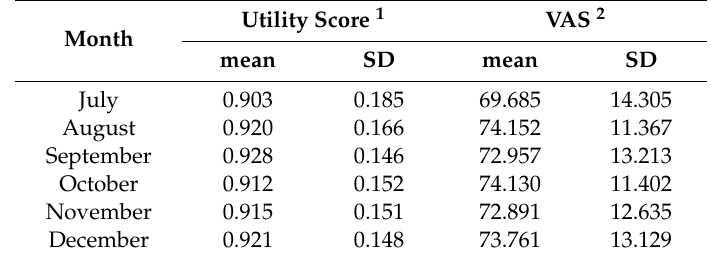
Table 2. Health-related quality of life (HRQoL) of hypertension patients over time. Utility Score Month